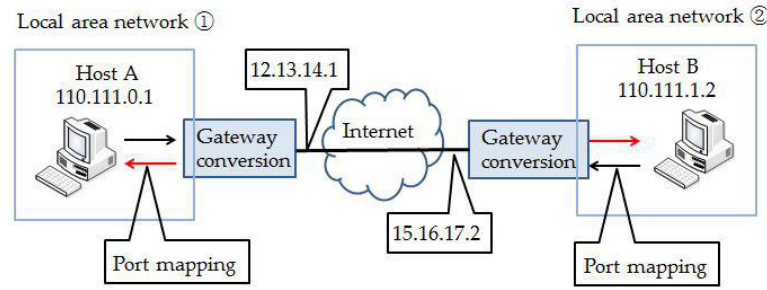
Figure 4. The schematic of intranet penetration technology.